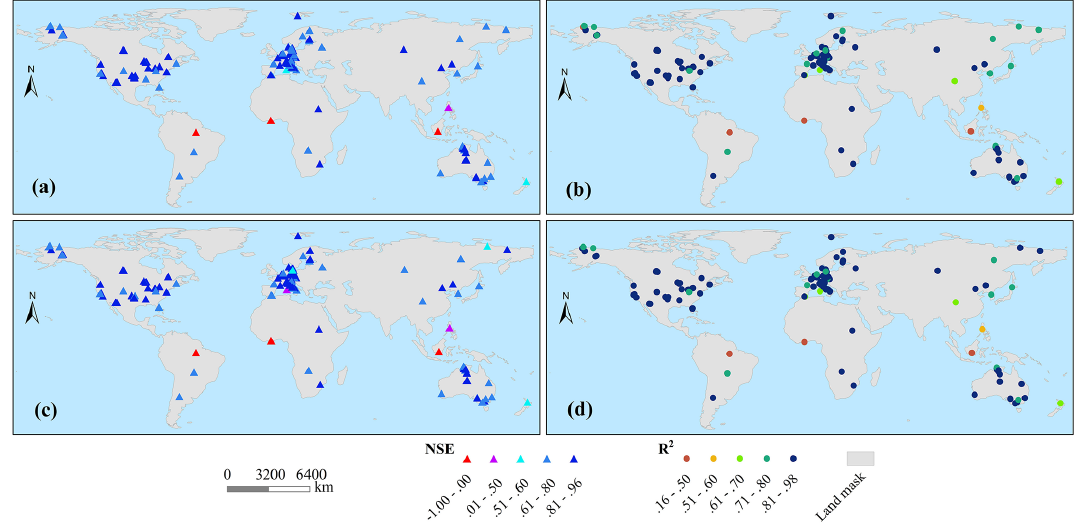
Figure 4. Spatial distribution of NSE and R 2 simulated by the sine function and EF( R e ) methods with multi-time values ( a and b are simulated by the sine function method, and c and d are simulated by the EF( R e ) method; a and c are NSE, and b and d are R 2 ).